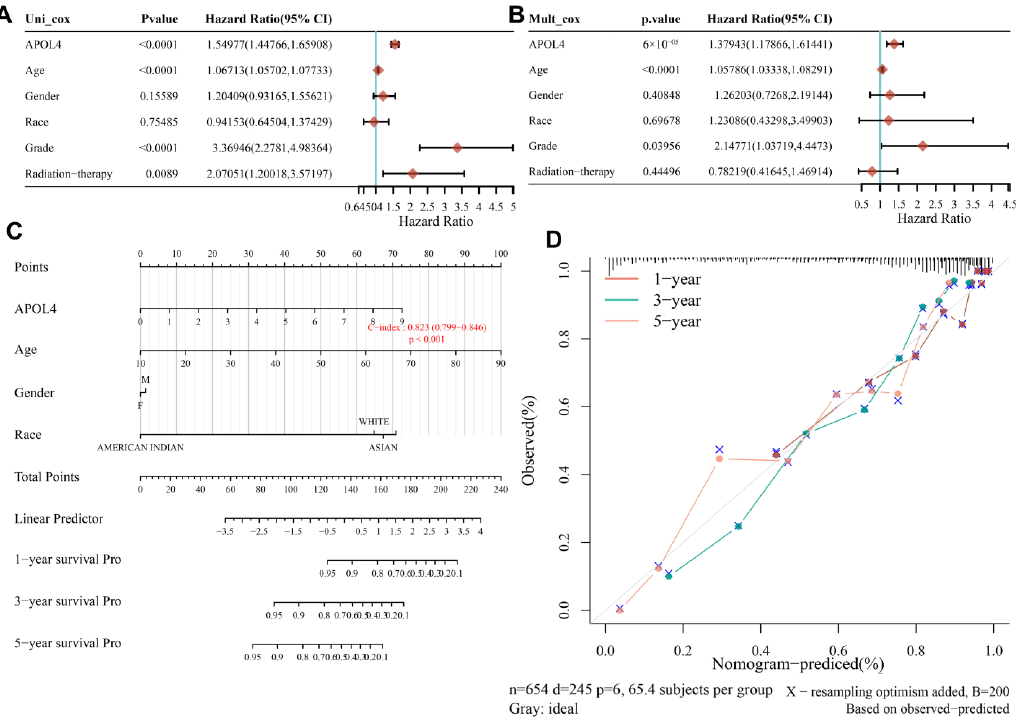
Figure 2. The prognostic value of APOL4. ( A , B ) Univariate and multivariate Cox regression. ( C ) Nomogram and calibration plots ( D ) predicting the OS of glioma patients.